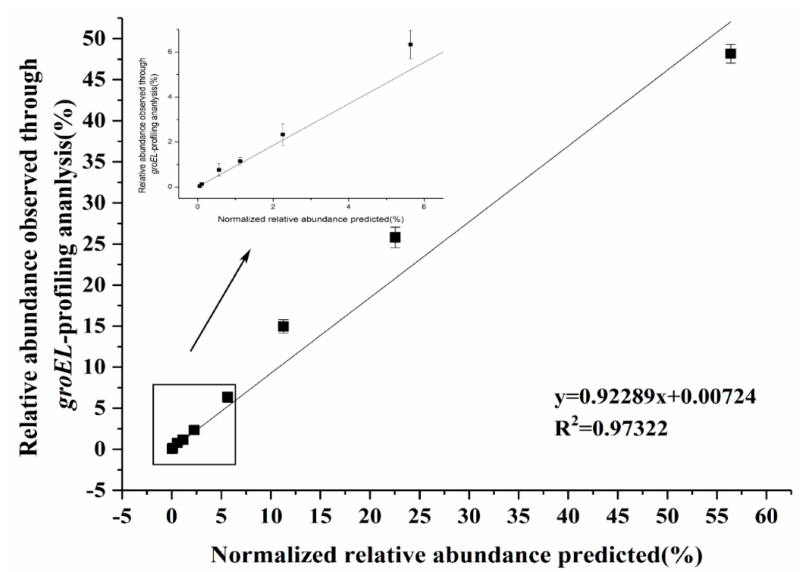
Figure 3. Accuracy and sensitivity of the new primer pair. The relative abundance of the predicted artificial Lactobacillus community was normalized, which was well consistent with the results of the analysis method based on the new primers. The linear regression equation is y = 0.92289x + 0.00724, and the y value represents the relative abundance observed through groEL -profiling analysis. The correlation index R 2 =